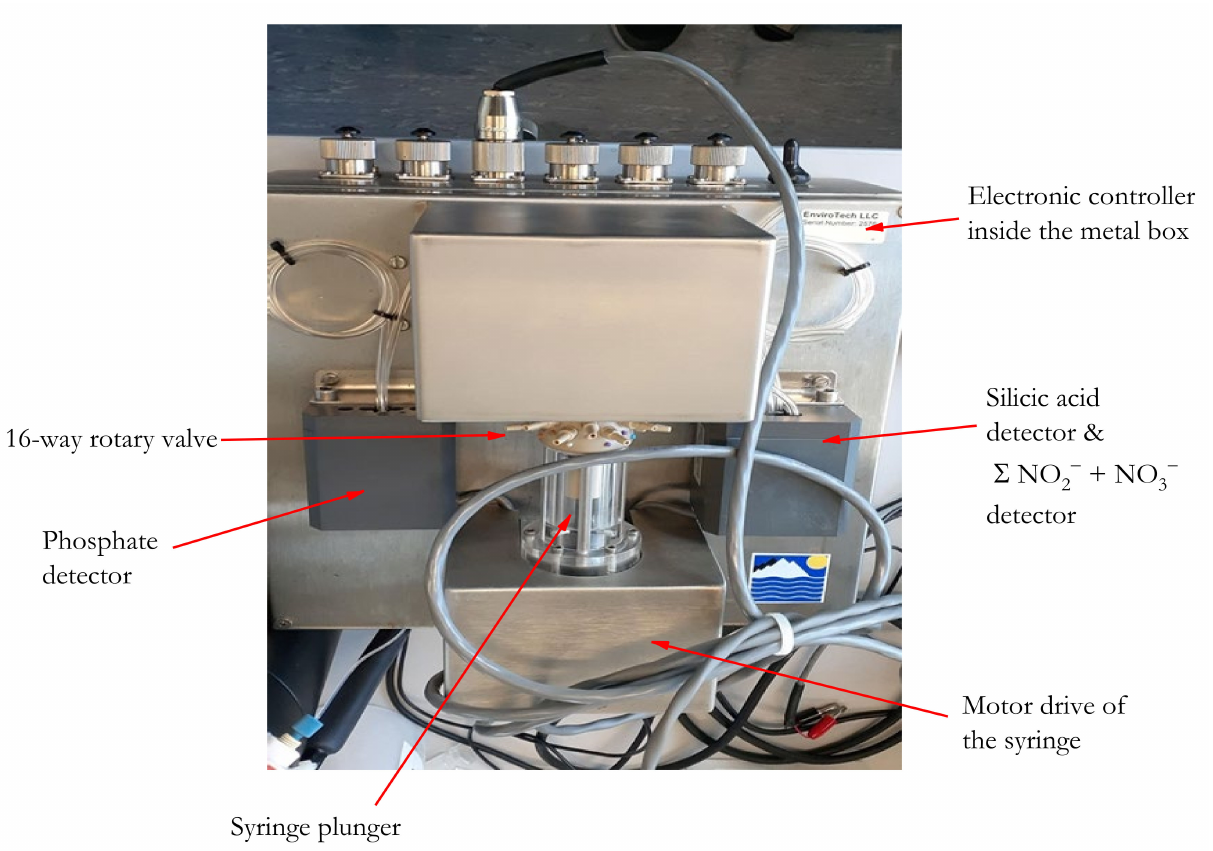
Figure 1. Hardware of multi-nutrient analyzer (AutoLAB) showing the five major components, namely, the 16-way rotary valves, a motor drive of the syringe, the syringe plunger, three colorimetric detectors, and an electronic controller inside a metal